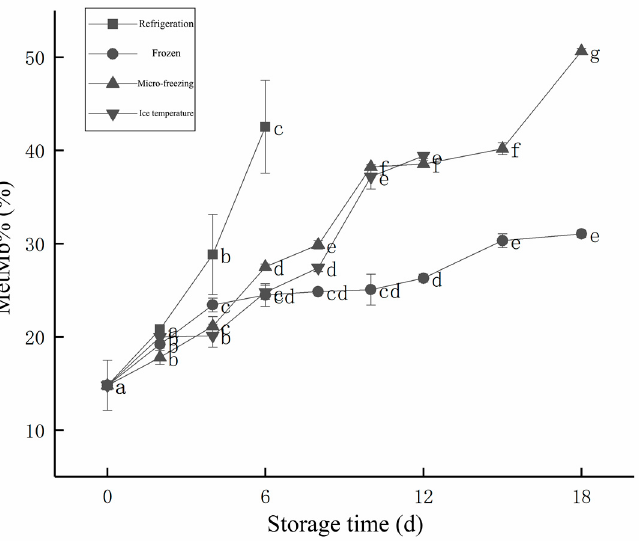
Figure 5. Changes of MetMb% during storage of beef with different cryopreservation methods. d, day.